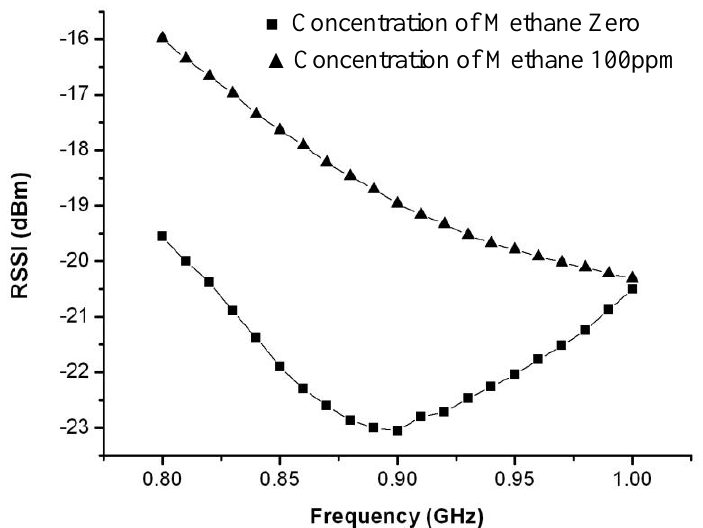
Figure 8. Variation of RSSI versus frequency with methane concentrations in ambient